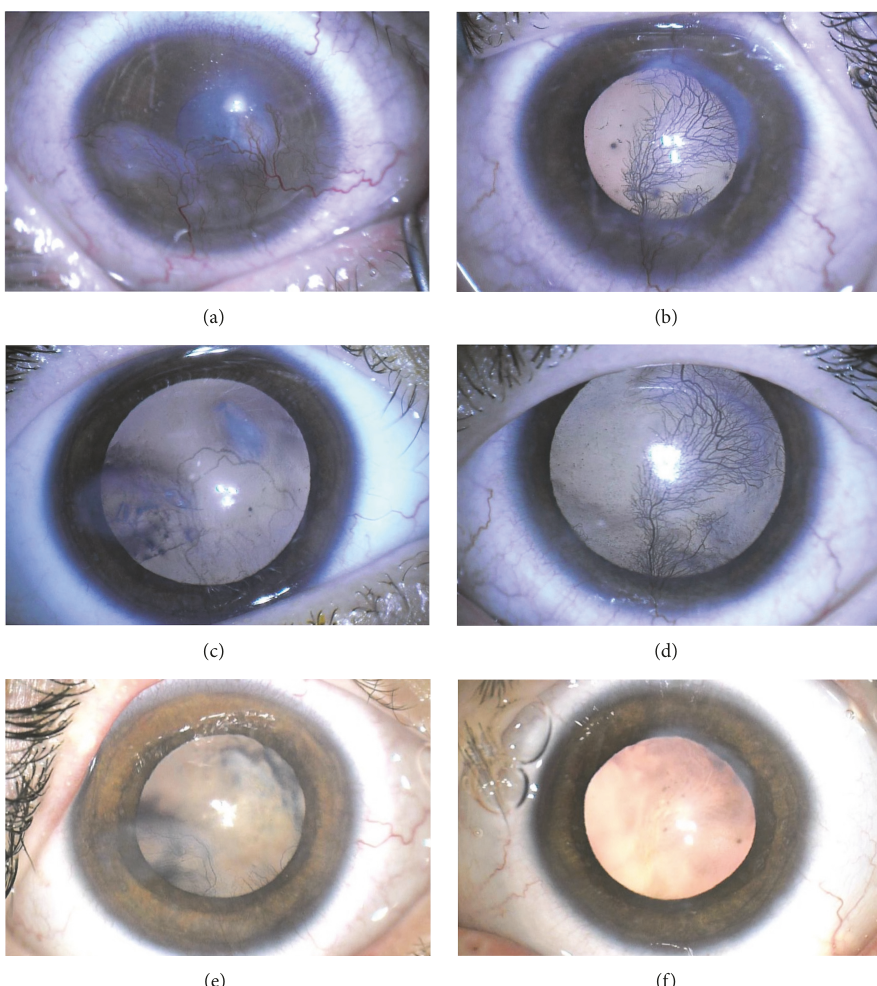
Figure 1: Photographs of Twin 1 with blepharokeratoconjunctivitis before and after treatment over a 10-month period. (a) Right cornea with infiltrate and overlying epithelial defect and corneal neovascularization. (b) Left cornea with central scar with active feeder vessels. (c) Right cornea eight weeks after subconjunctival triamcinolone and bevacizumab injections showing fading stromal infiltrates and regressed bloods vessels. (d) Left cornea in eight-week time with no injections showing persisting corneal neovascularization, and no observable benefit from systemic effect of bevacizumab. (e) Right cornea 10 months after bilateral subconjunctival triamcinolone and bevacizumab injections and 5 months after additional triamcinolone injections, with central corneal scarring and suppressed blood vessels. (f) Left cornea 8 months after bilateral subconjunctival triamcinolone and bevacizumab injections and 5 months after additional triamcinolone injections and diathermy with central corneal scarring and suppressed blood